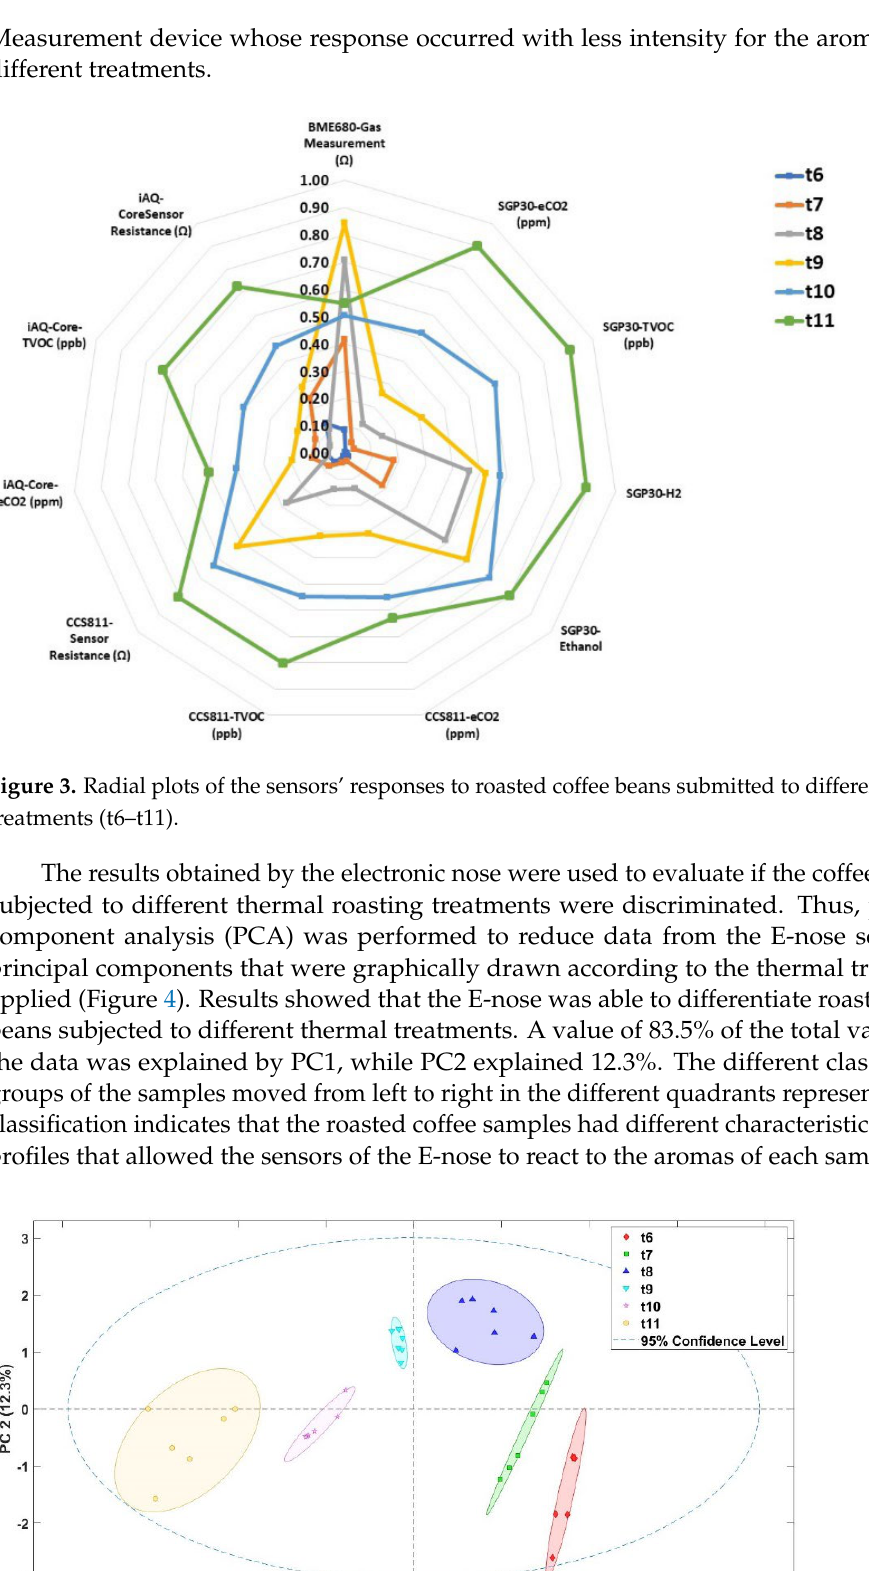
Figure 4. Score plot of the principal component analysis (PCA) for roasted coffee beans submitted to different thermal treatments (t6–t11).